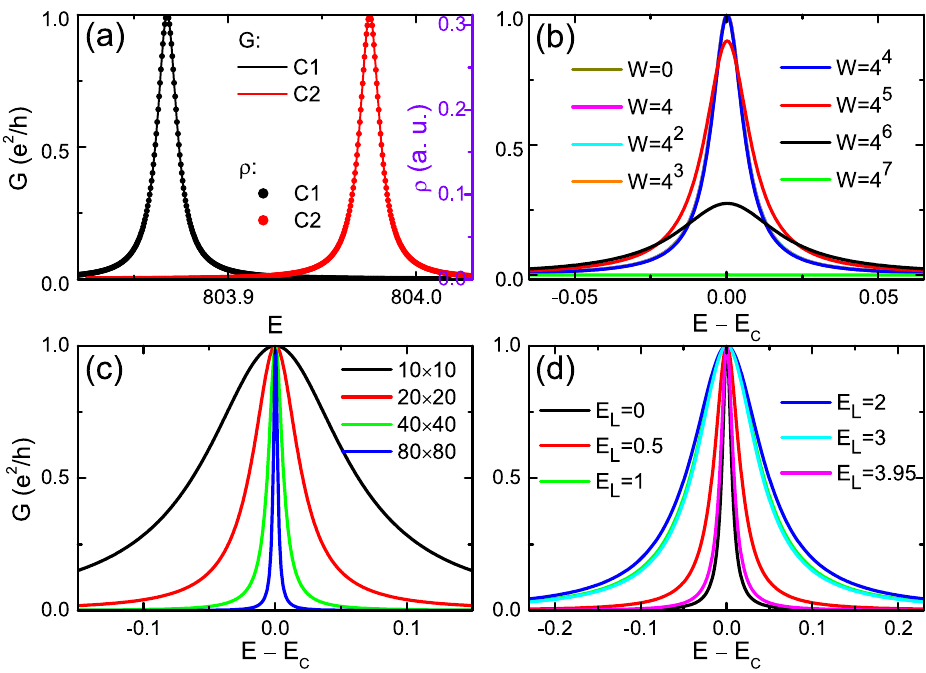
Figure 8. (Color online) Two-terminal conductance G as a function of the Fermi energy in the sample, for the extended isolated state. ( a ) For two disorder configurations, C1 (black curve) and C2 (red curve). The corresponding DOS ρ (referenced to the right axis) are also plotted as dots. ( b ) For different disorder strengths W . ( c ) For different sample sizes. ( d ) With different energies E L in leads. If not otherwise stated in the panel, parameters are as follows: W = 16 , E L = 0 and size 40 × 40 . In panels ( b ), ( c ) and ( d ), all curves have been horizontally shifted to the same peak